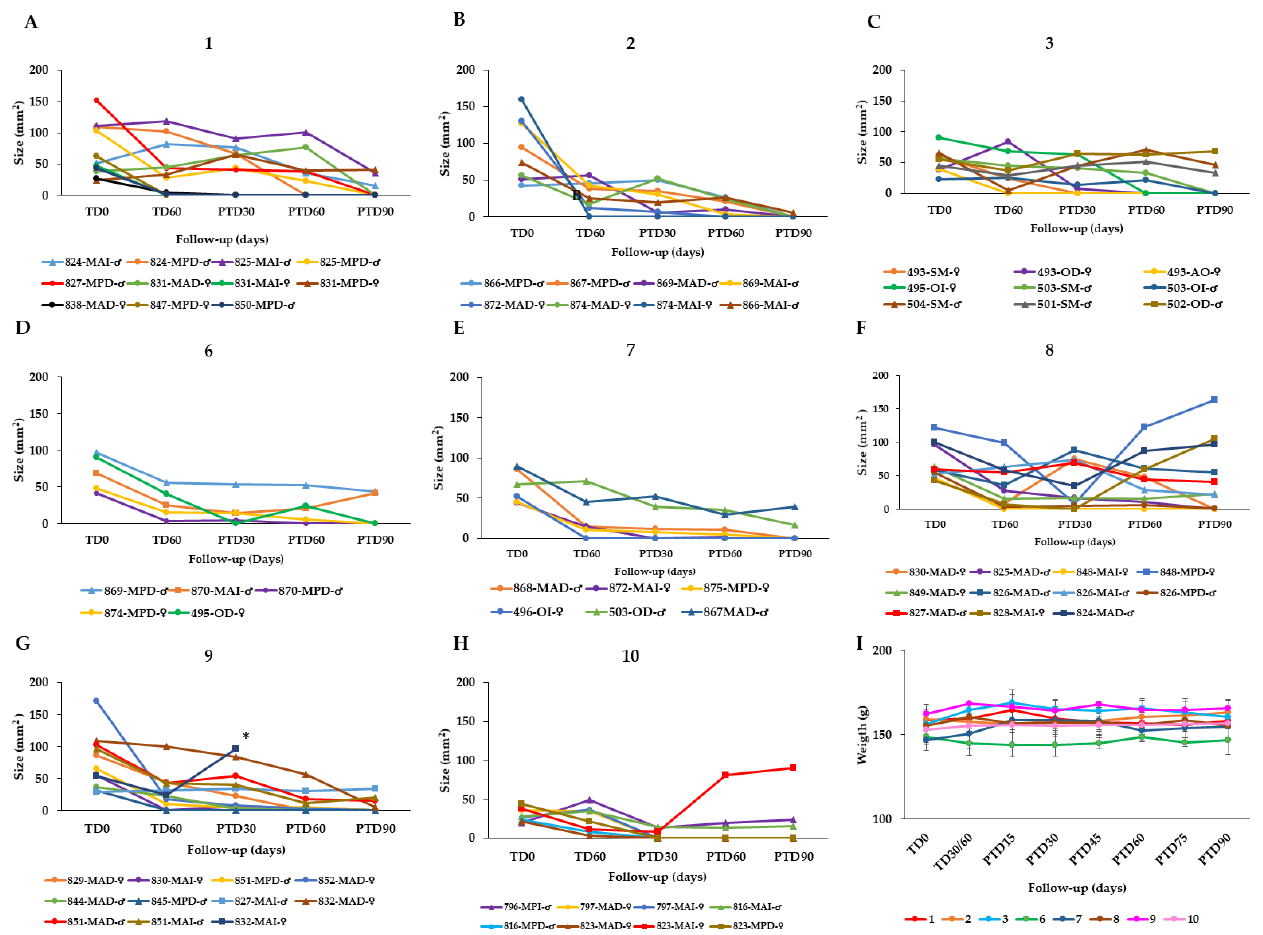
Figure 2. Effect of the topical AT treatment in golden hamsters with cutaneous leishmaniasis caused by Leishmania braziliensis . The figure shows the development of the lesion size in each hamster during the study in mm 2 measured at various time points (graphics ( A – G )). Disease progression was monitored before treatment administration (TD0), at the end of treatment (TD60) and on days 30, 60 and 90 post-treatment (PTD30, PTD60 and PTD90, respectively). ( A ): Group 1 ; L. braziliensis , 19.2 μg total STL, 1 × day, 60 days; ( B ): Group 2 ; L. braziliensis , 19.2 μg total STL, 2 × day, 60 days; ( C ): Group 3 ; L. braziliensis , 38.4 μg total STL, 2 × day, 60 days; ( D ): Group 6 ; hamsters infected with L. braziliensis treated with 40 mg DOC Arnica 21, 5% Creme (DAC; 4.0 μg total STL), 2 × day, 60 days; ( E ): Group 7 ; hamsters infected with L. braziliensis treated with 40 mg Arnica Salbe S Kneipp